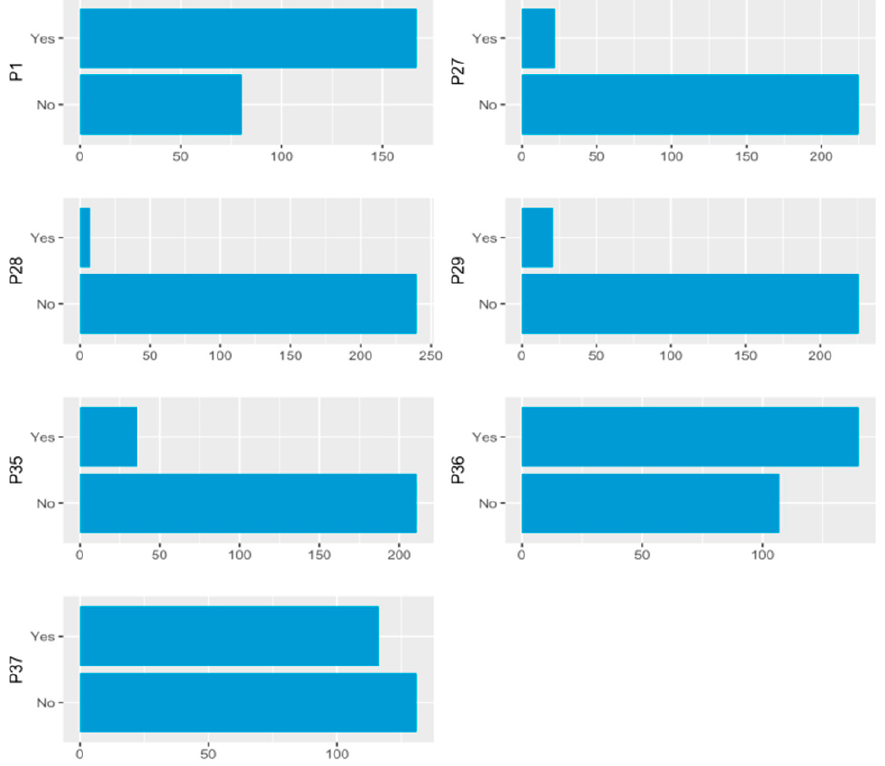
Figure 3. Summary of responses to questions with categorical responses from two categories. Source: compiled by the authors.